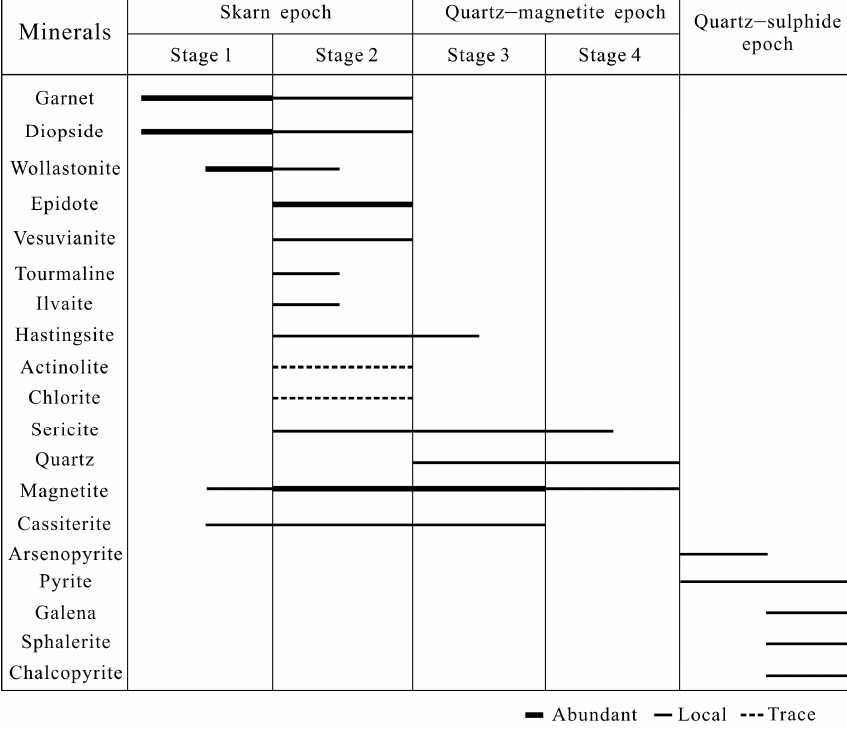
Figure 4. Paragenetic sequence of minerals from the Huanggangliang Sn-Fe deposit.